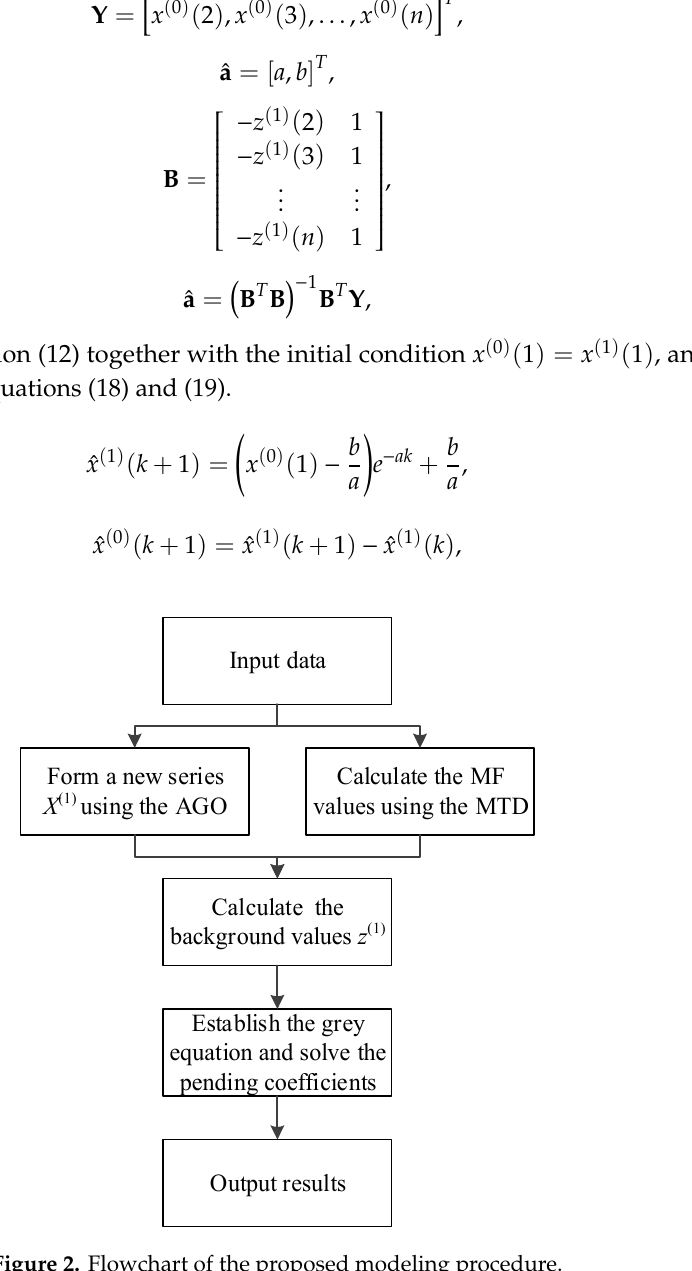
Figure 2. Flowchart of the proposed modeling procedure.